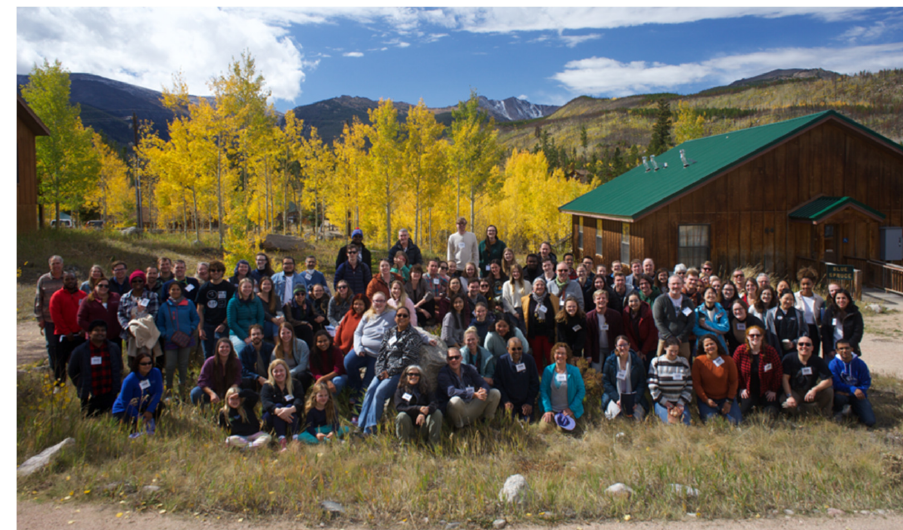
Figure 1. Attendees at the 22nd Rocky Mountain Virology Association